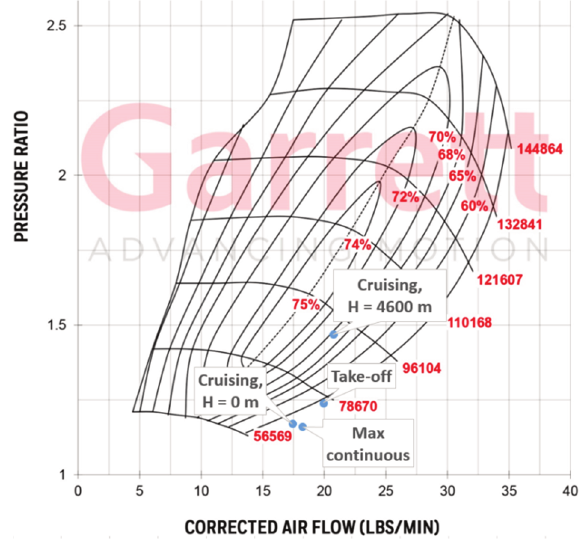
Fig. 10. Garrett GT-2560R turbocharger map with calculated operating points